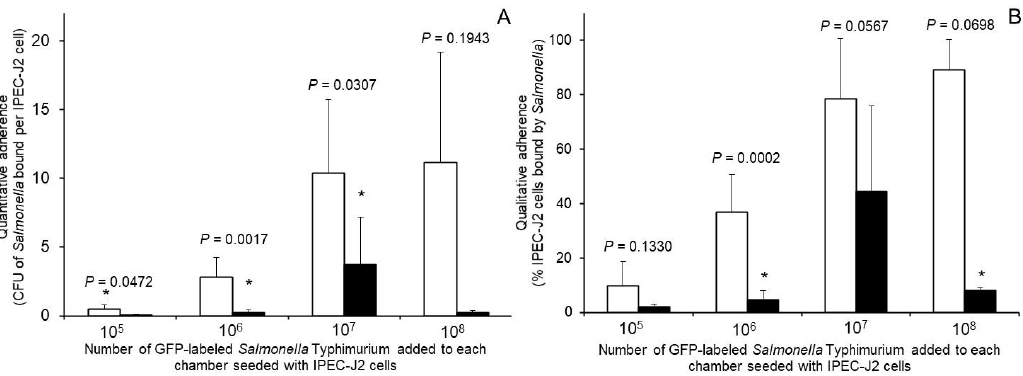
Figure 2. Effect of pre-exposing green fluorescent protein (GFP)-labeled Salmonella Typhimurium (black bars) with 18 mg wood-derived prebiotic/mL of medium on this bacterium’s quantitative ( A ) and qualitative ( B ) adherence to a non-immortalized porcine derived jejunal cell line (IPEC-J2). Control GFP-labeled S. Typhimurium exposed to medium alone are presented with white bars. Asterisks denote decreased adhesion ( p < 0.05) of the GFP-labeled S. Typhimurium that had been pre-exposed to the wood-derived prebiotic when compared to its control.